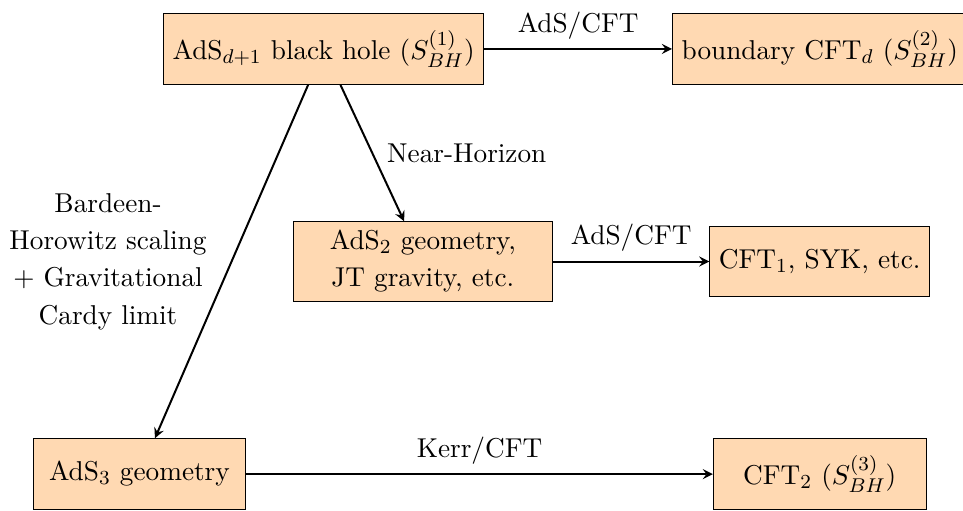
Figure 1 . The Gravitational Cardy limit plays a role in the broader picture of the study of AdS black holes, giving us a near-horizon AdS 3 geometry, similar to that of the extremal vanishing horizon limit. The entropy can be computed in three separate regimes ( S ( i ) be